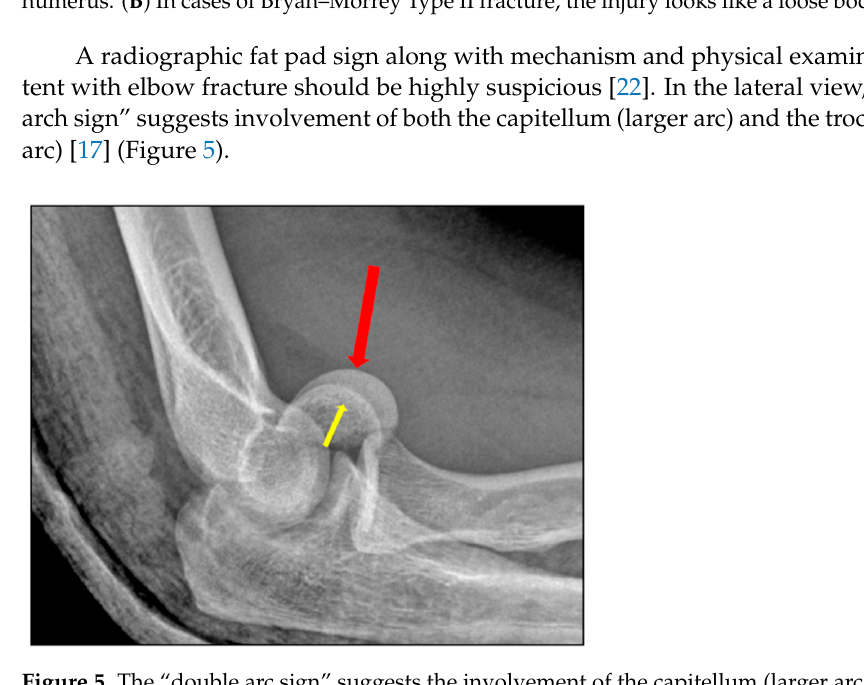
Figure 5. The “double arc sign” suggests the involvement of the capitellum (larger arc, red arrow) as well as the trochlea (smaller arc, yellow